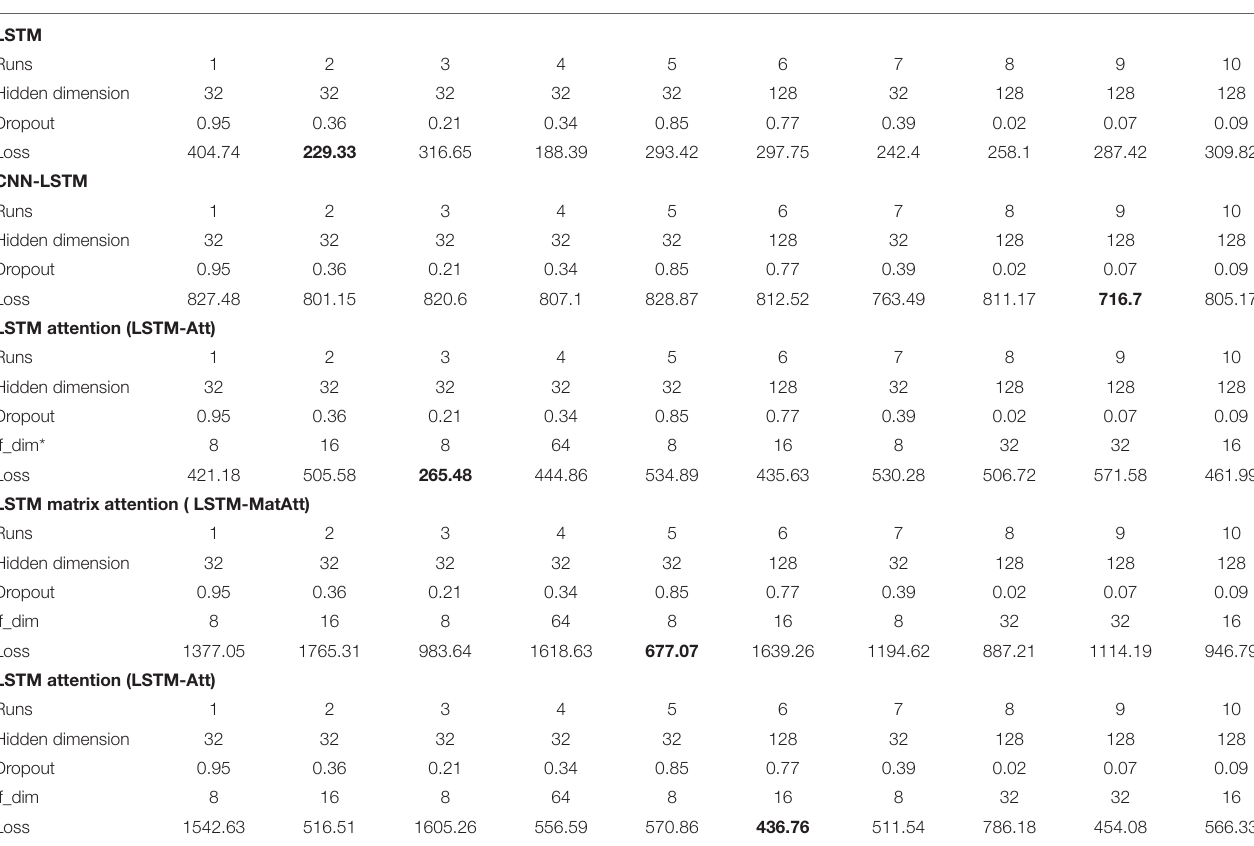
TABLE 1 | Parameters tuning of LSTM models.